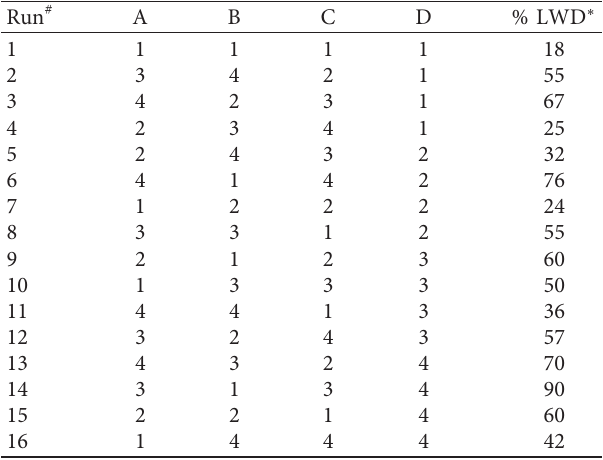
Table 3: Taguchi L16 experimental matrix